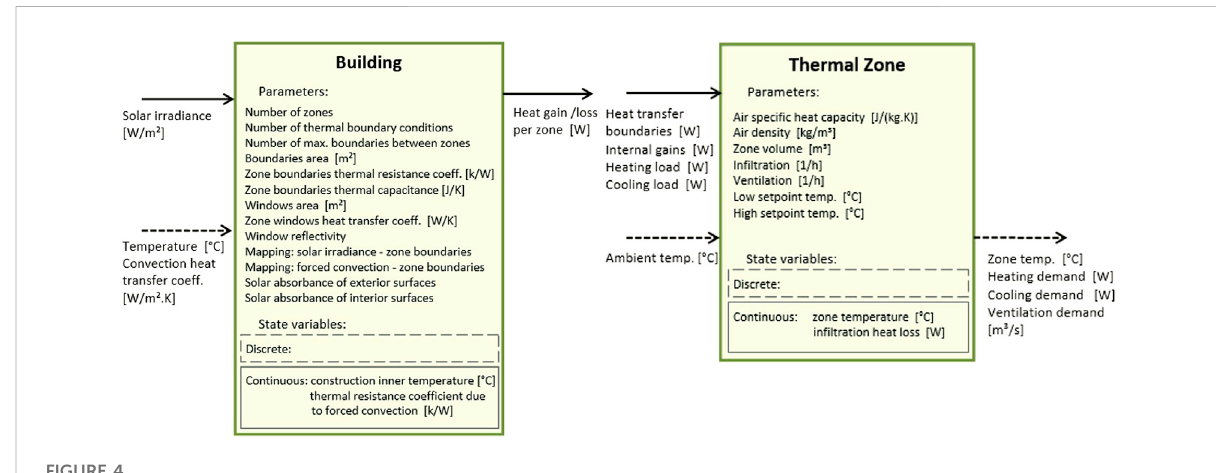
FIGURE 4 Schematic representation of the building and thermal zone